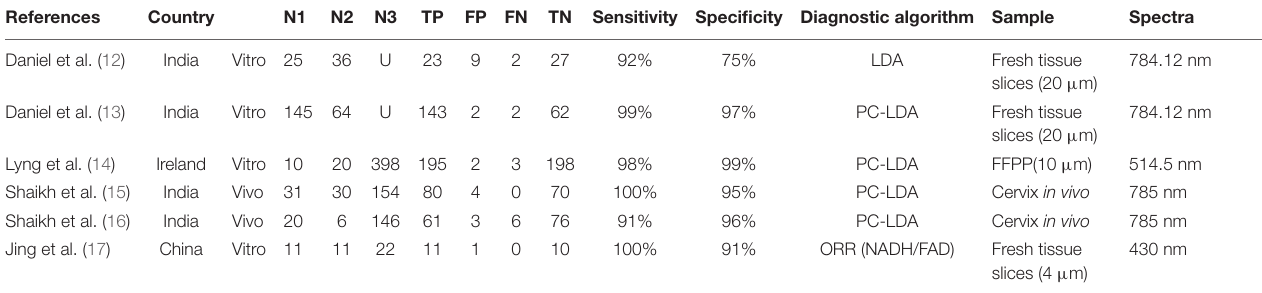
TABLE 1 | Characteristics of the included studies.